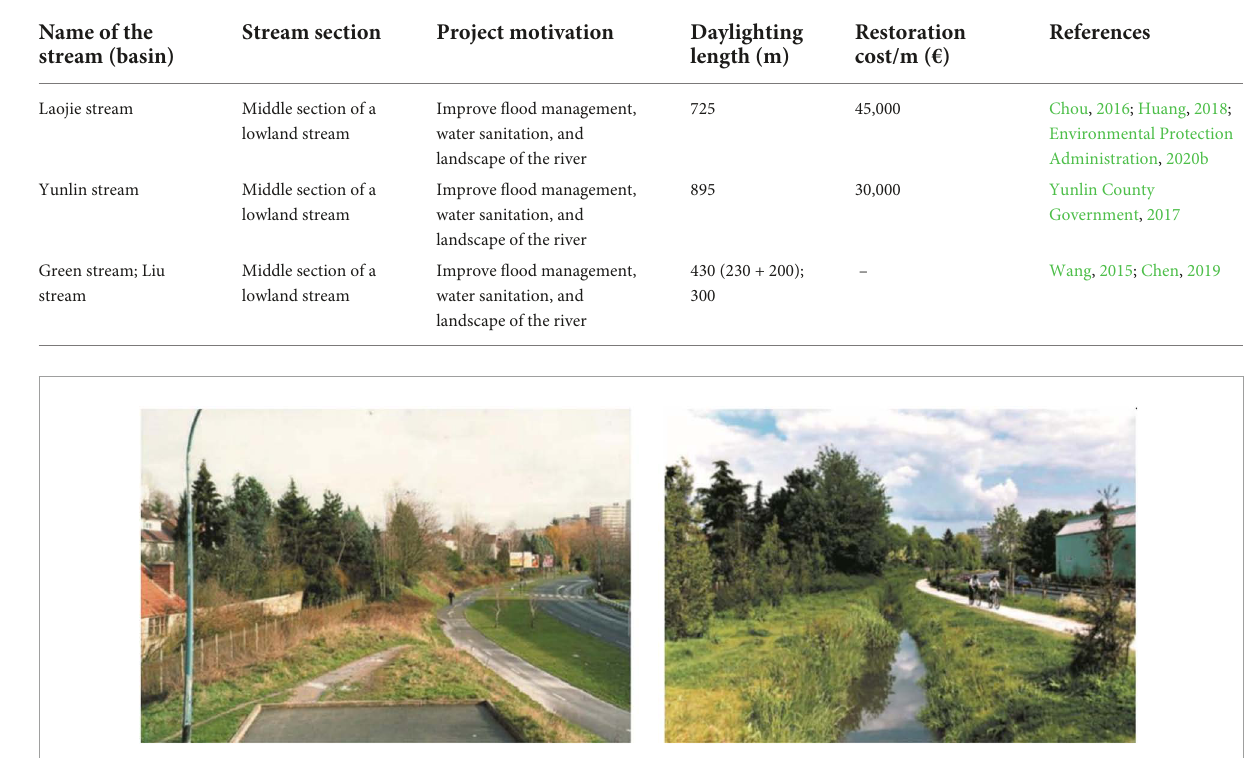
TABLE 6 Daylighting projects in Taiwan.